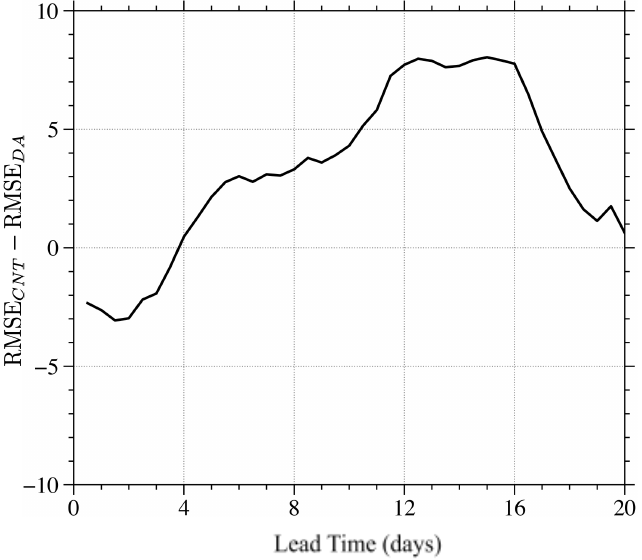
Figure 8. The differences in root mean squared errors (RMSE) between the control and DA experi- Fig. 8: The differences in root mean squared errors (RMSE) between the control and DA ments with respect to the forecast lead time. experiments with respect to the forecast lead time.